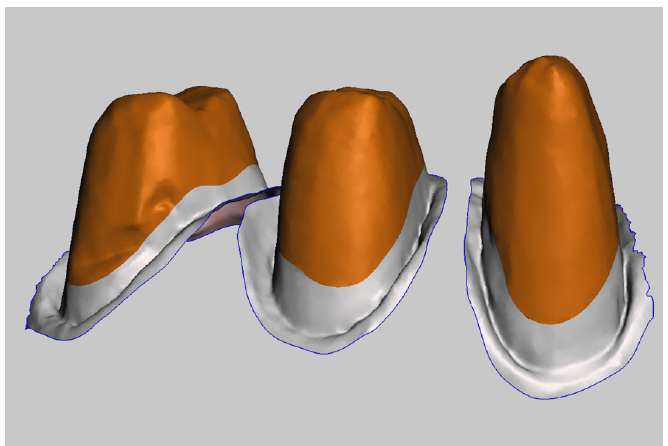
Figure 11. Selection of the zones in the intraoral digital impression that are important to maintain.